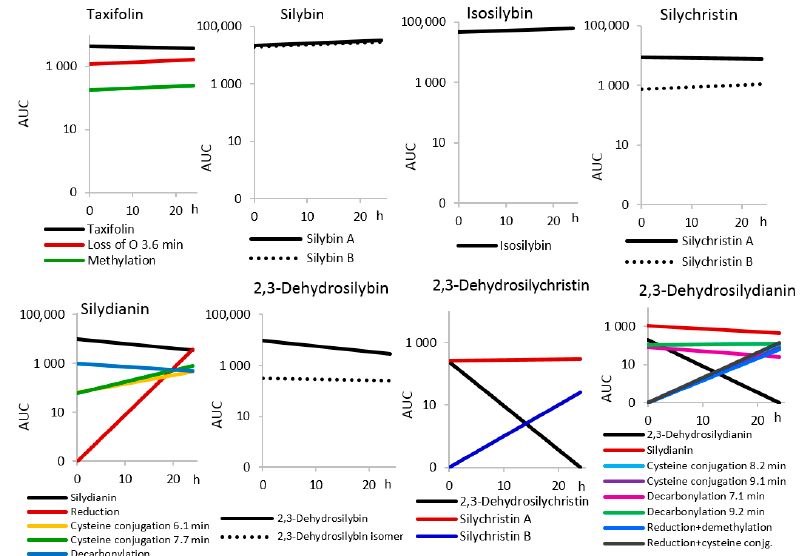
Figure A1. Stability of the compounds tested in the incubation medium without fecal microbiota.